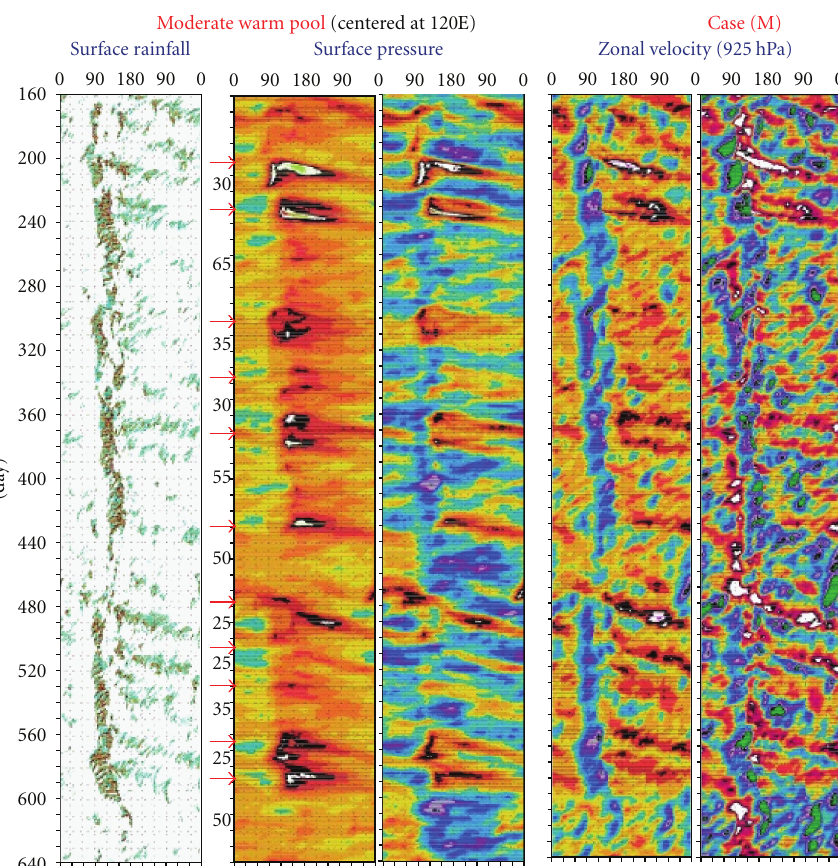
Figure 3: Same as Figure 2 but for case